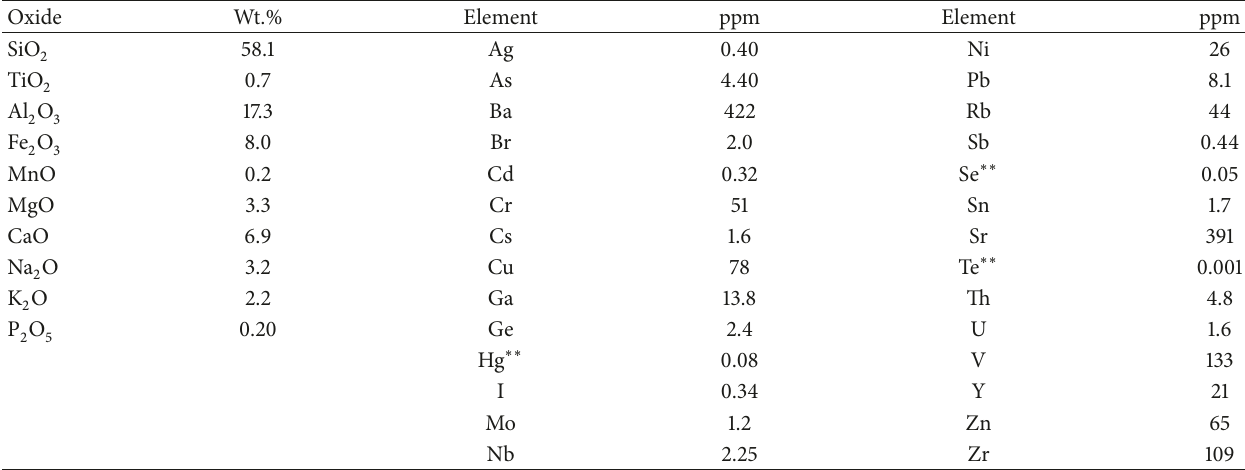
Table 1: Average composition of Ebeko andesites ∗